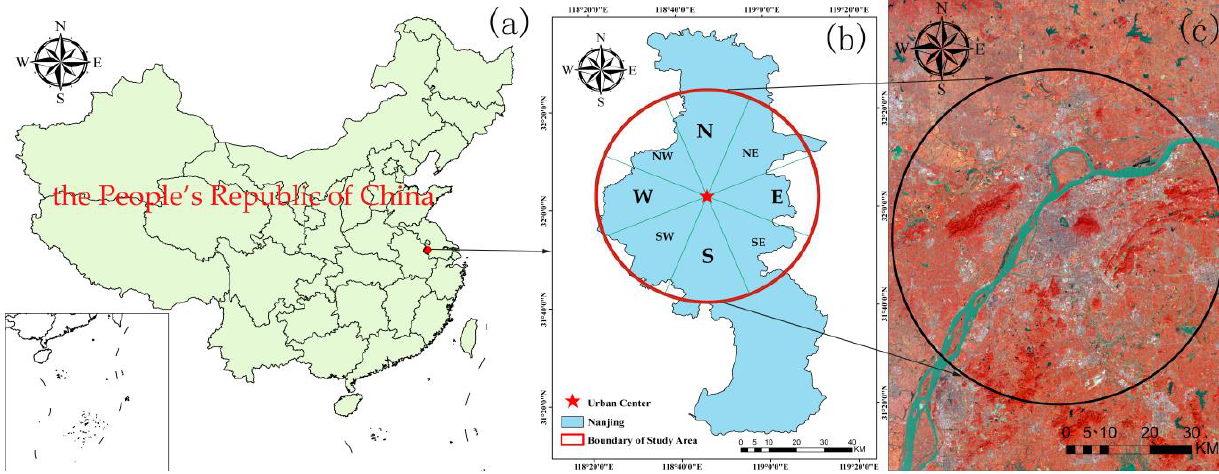
Figure 1. Map of study area of Nanjing, China.(a) Location of study area in China; (b) Division of study area; (c) Landsat 8 OLI false color composition image of study